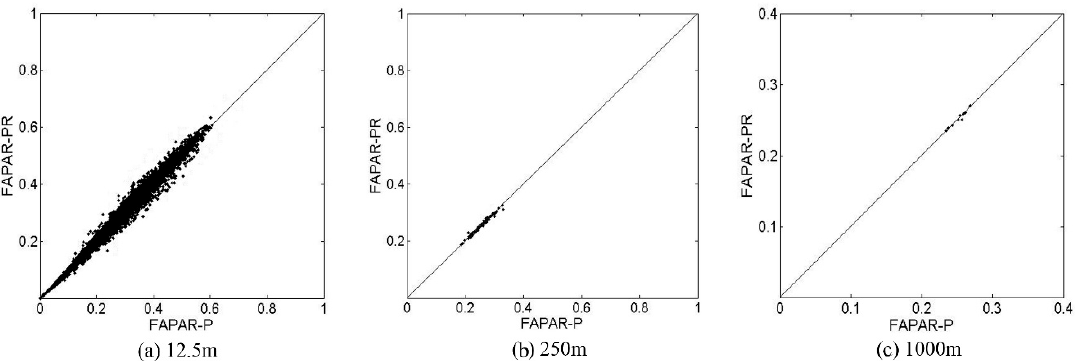
Figure 13. Difference between the FAPAR values at Saihanba calculated using the FAPAR-PR and FAPAR-P models at different scales: ( a ) 12.5 m; ( b ) 250 m; ( c ) 1000 m.